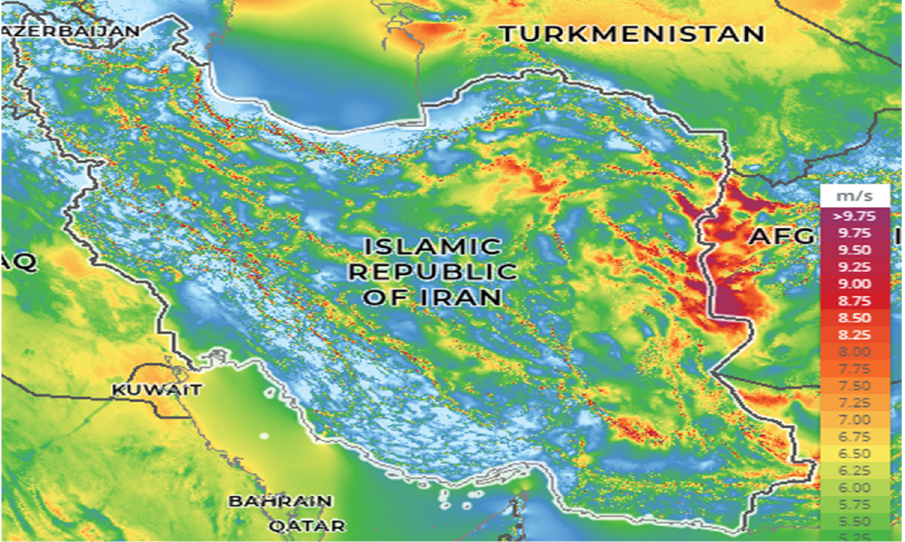
Figure 5. Wind atlas of Iran at height 50 m. Source: https://globalwindatlas.info/area/Is-